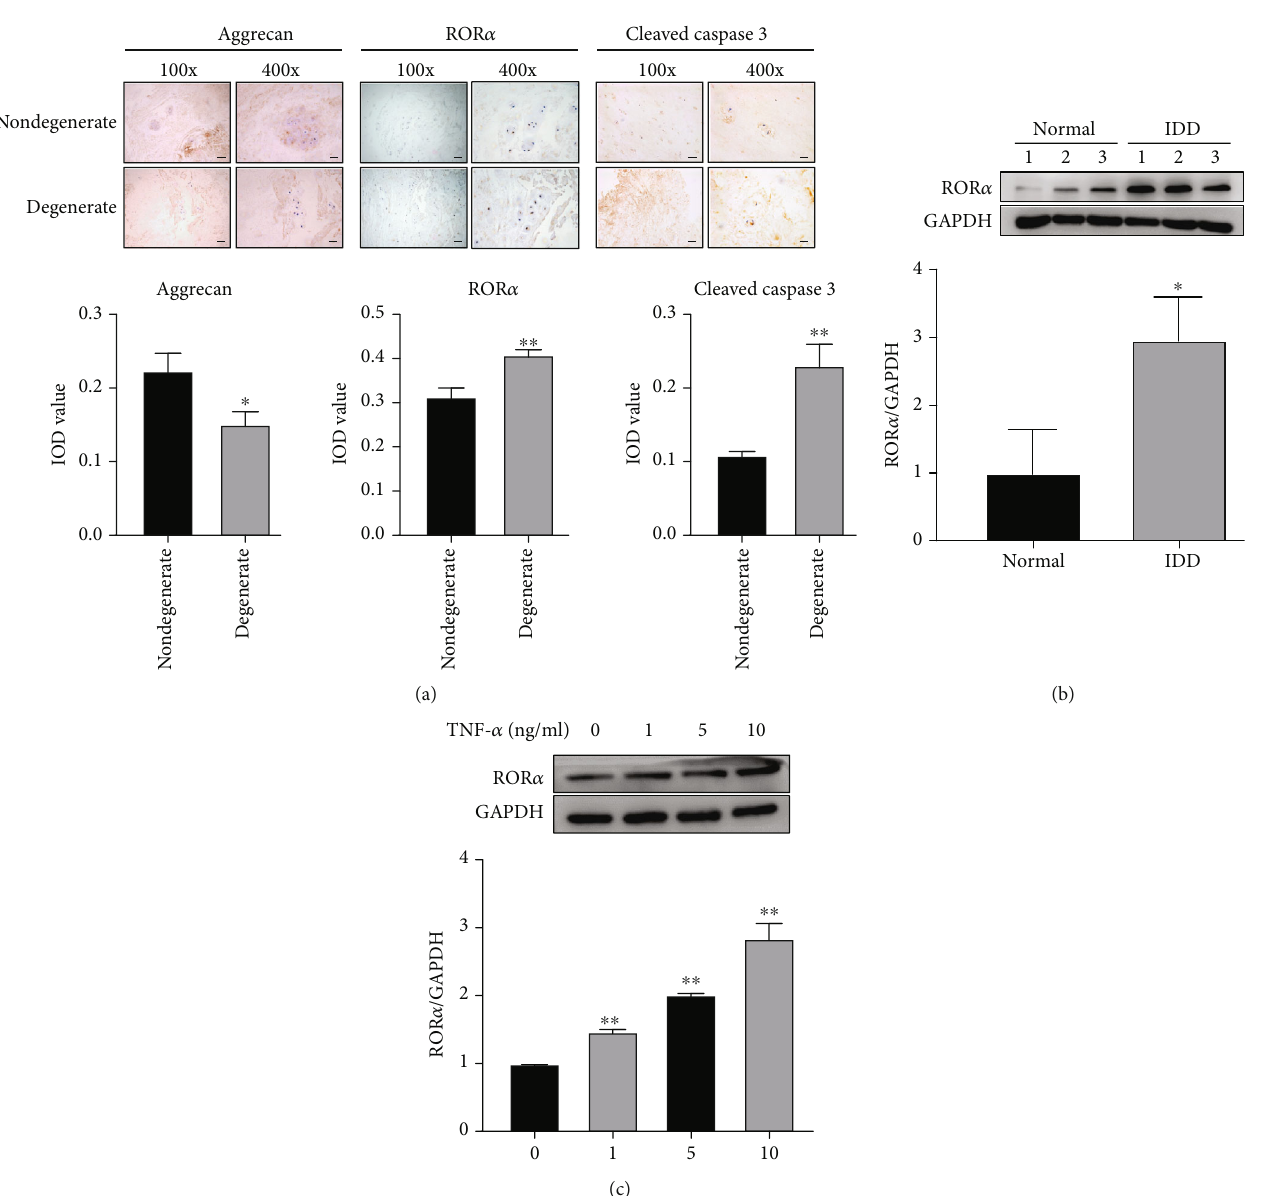
Figure 1: Upregulation of ROR α during the process of degeneration of NP tissue. (a) The expression of aggrecan, ROR α , and cleaved caspase 3 in normal or degenerated human nucleus pulposus tissue is shown by immunohistochemistry staining. The IOD value for the picture is shown. Scale bar = 200 μ m for the 100x image, 50 μ m for the 400x image. N = 3 . (b) Protein levels of ROR α in the nucleus pulposus tissue of normal control and IDD patients were determined by western blot analysis. Quantitative analysis of ROR α is shown below. ∗ p < 0 : 05 compared with normal control. (c) Protein levels of ROR α in human NP cells treated with the indicated concentration of TNF- α . Quantitative analysis is shown below. ∗∗ p < 0 : 01 compared with the vehicle group. Data are expressed as mean ± SD . All experiments were repeated three